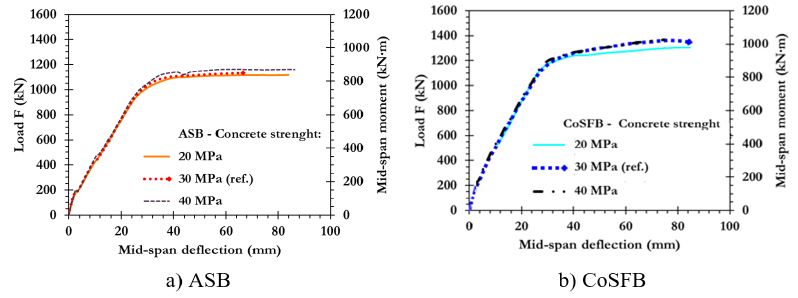
Figure 19. Load-deflection curve – Concrete